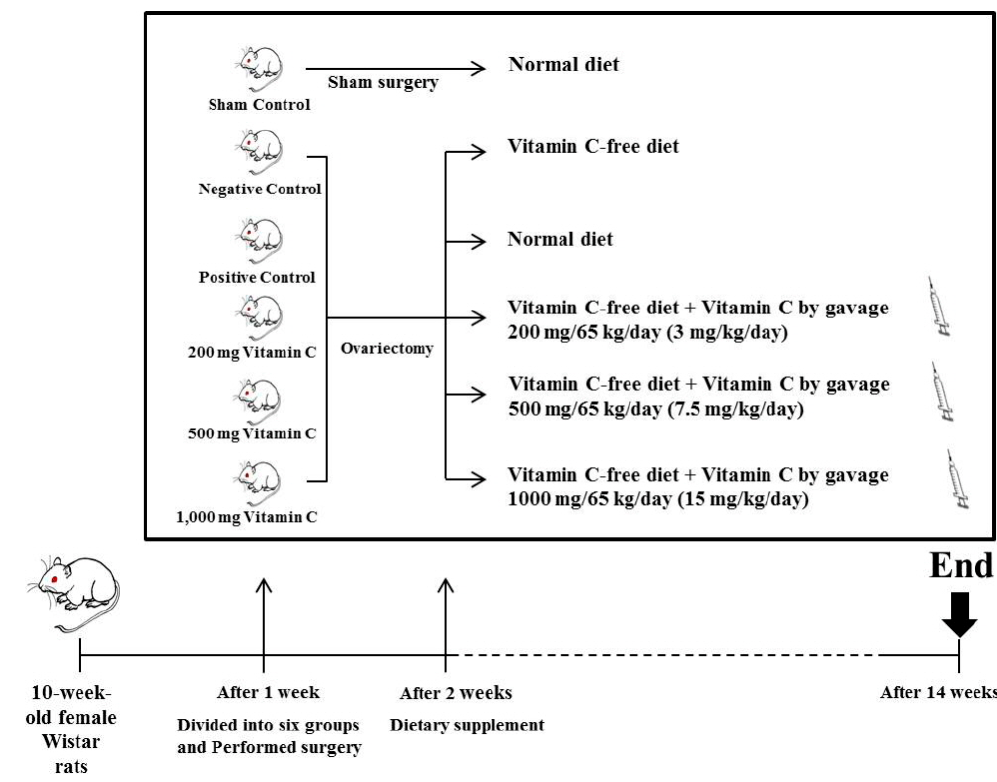
Figure 1. Scheme of animals and diet.